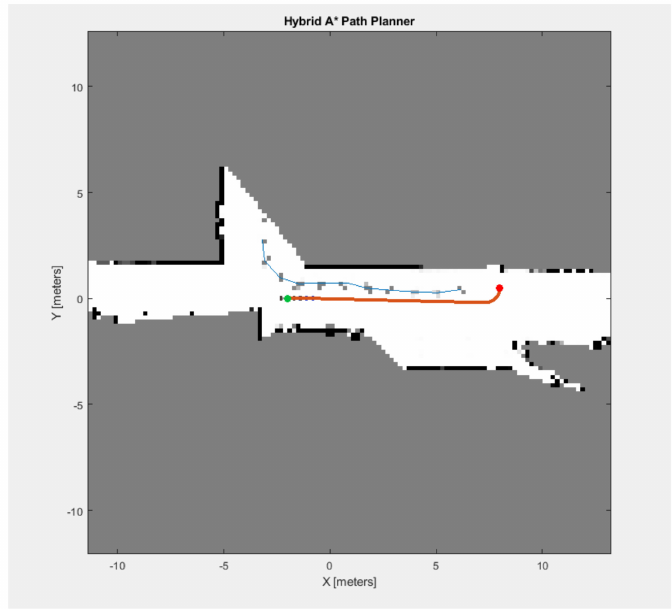
Figure 11. Navigation map with applied navigation algorithm.